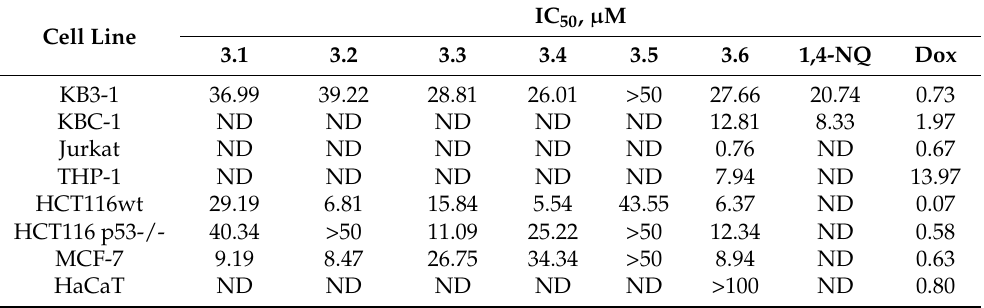
Table 2. Influence of Compounds and 1,4-NQ on the Growth of Individual Tumor Cell